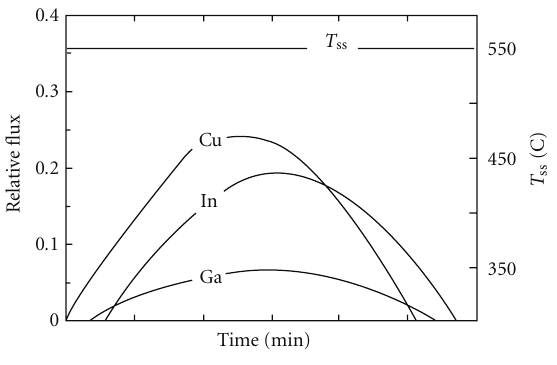
Figure 5: Flux distributions of di ff erent elements for in-line system. A constant Se flux is also supplied (from